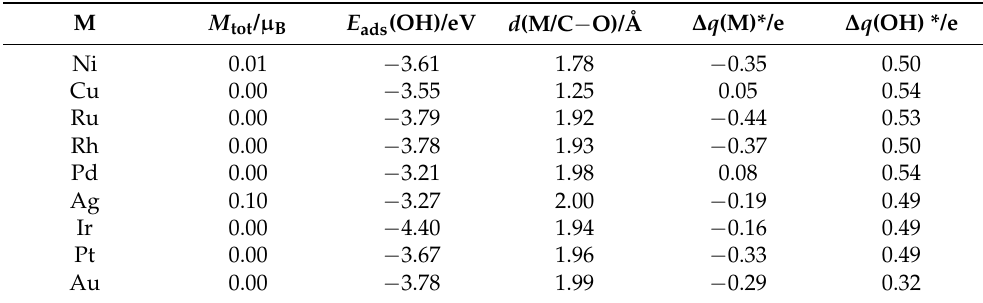
Table 3. The OH adsorption on the most stable site of M@vG: total magnetizations ( M tot ), OH adsorption energies ( E ads (OH)), relaxed M − O or C − O distance (depending on the OH position, d (M/C − O)), change of the Bader charge of M upon adsorption ( ∆ q (M)) and change of the Bader charge of OH upon adsorption ∆ q (OH).